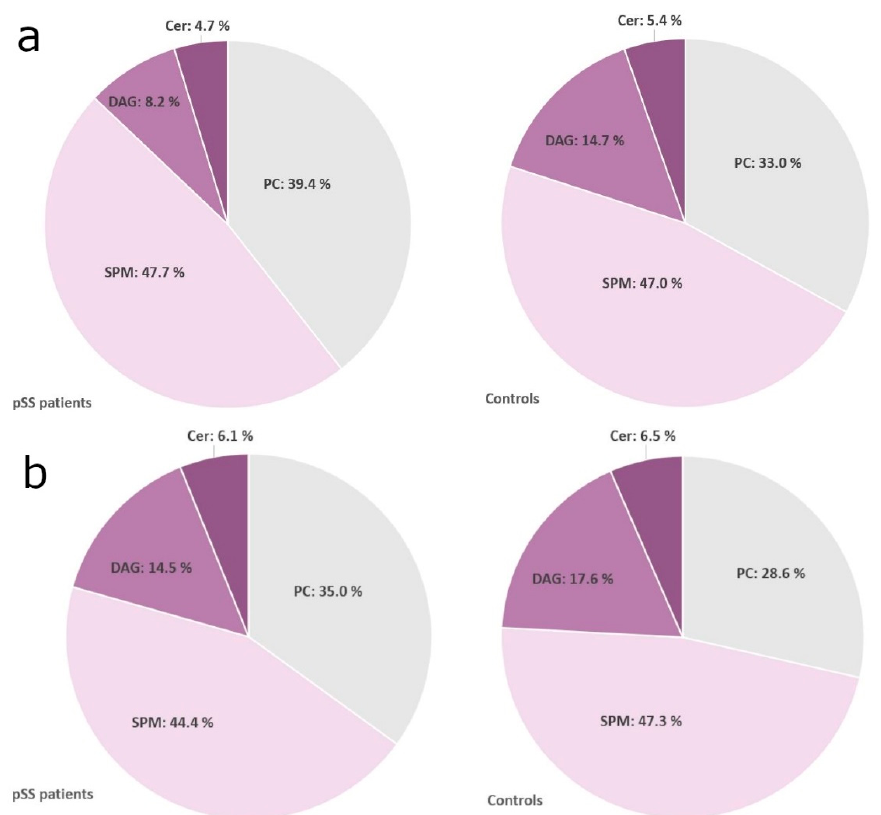
Figure 1. Lipid composition of saliva. ( a ) Unstimulated whole saliva; ( b ) stimulated whole saliva. pSS: primary Sjögren’s syndrome; PC: diacylglycerophosphocholine; SPM: sphingomyelins; DAG: diacylglycerols; Cer: ceramides. The most abundant lipid classes in both unstimulated and stimulated whole saliva were SPM, PC, and DAG, with a smaller contribution of Cer.